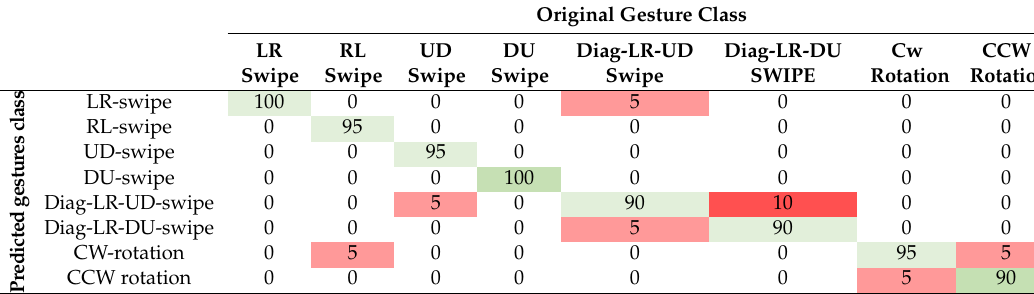
Table 3. Classification accuracy of each gesture. Intensity of green and red colors represent the intensity of classification accuracy and error